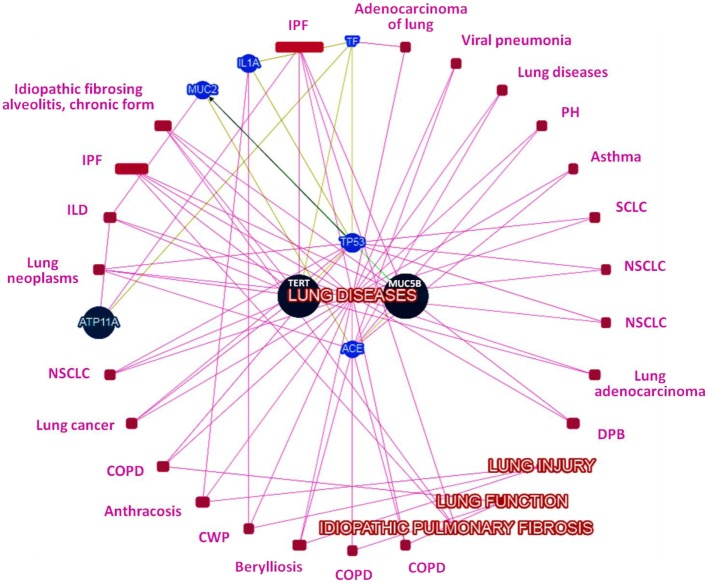
Network of genes with candidate loci and their interaction with IPF, lung injury, lung function, and lung disease phenotypes (ILD, interstitial lung disease; CWP, coal worker’s pneumoconiosis; COPD, chronic obstructive pulmonary disease; DPB, diffuse panbronchiolitis; NSCLC, non-small cell lung cancer; SCLC, small cell lung cancer; PH, pulmonary hypertension).